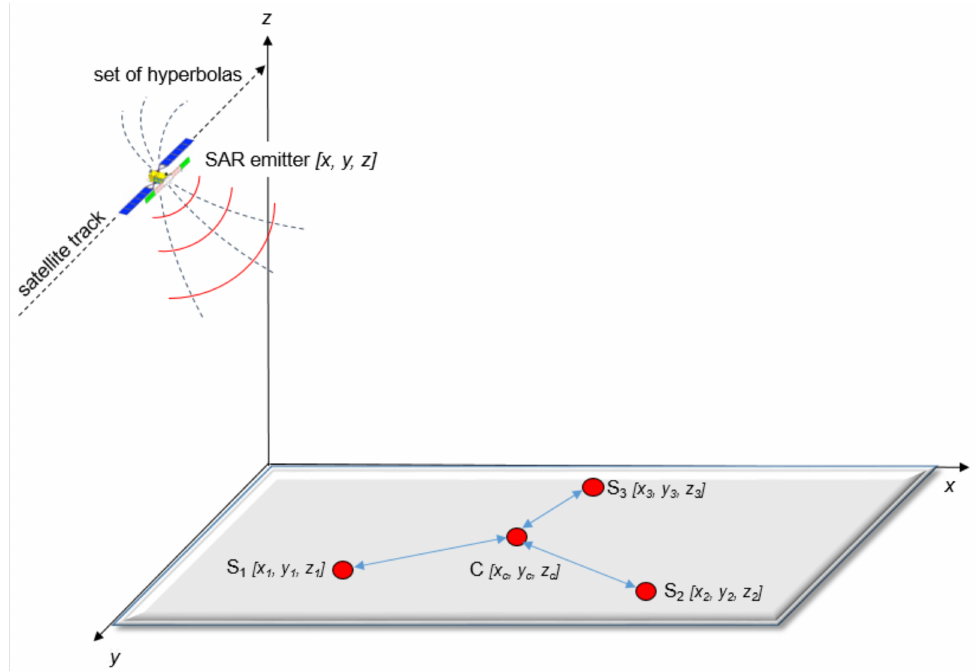
Figure 2. General configuration of ESM MLAT